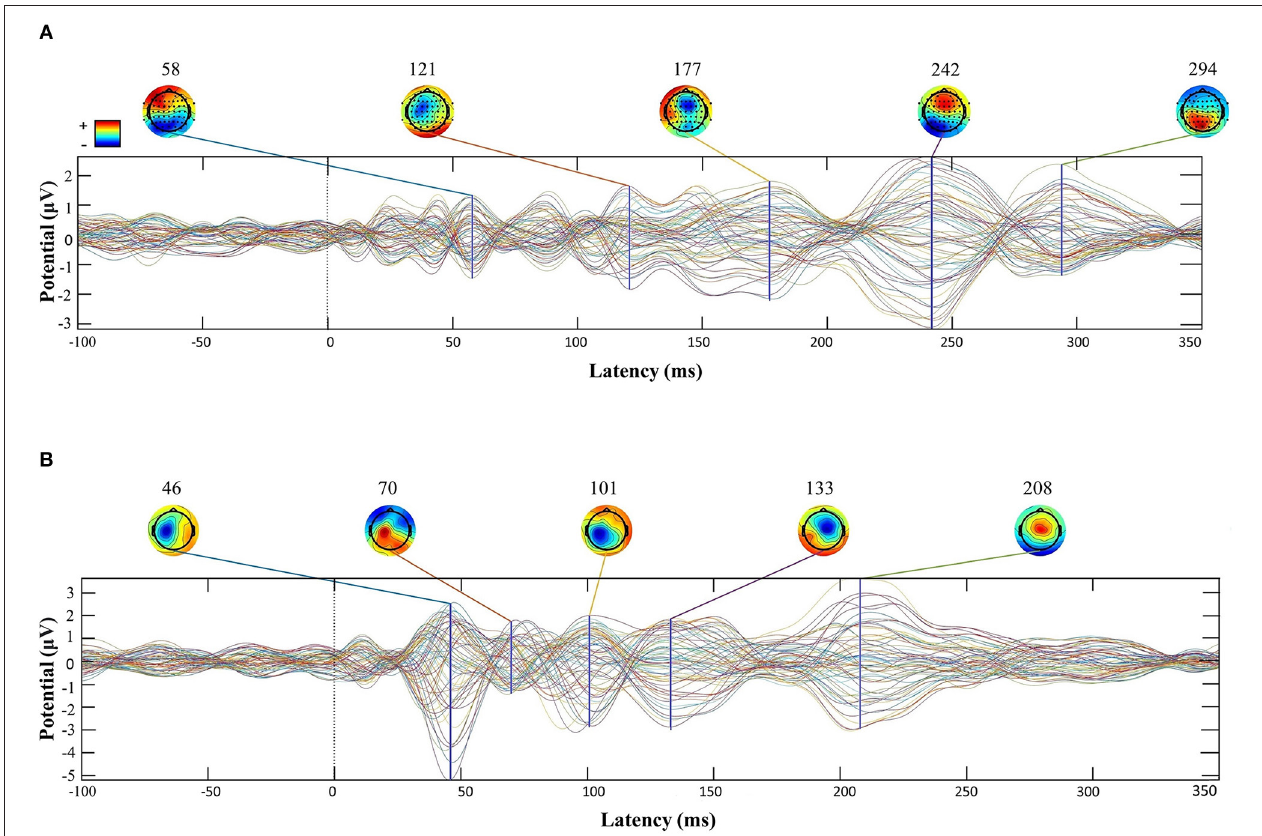
FIGURE 3 | Butterfly plots of a subject’s TMS-EEG responses after PFC (A) and IPL (B) stimulation. Each figure time-series are plotted − 100 to + 400ms around the TMS pulse.